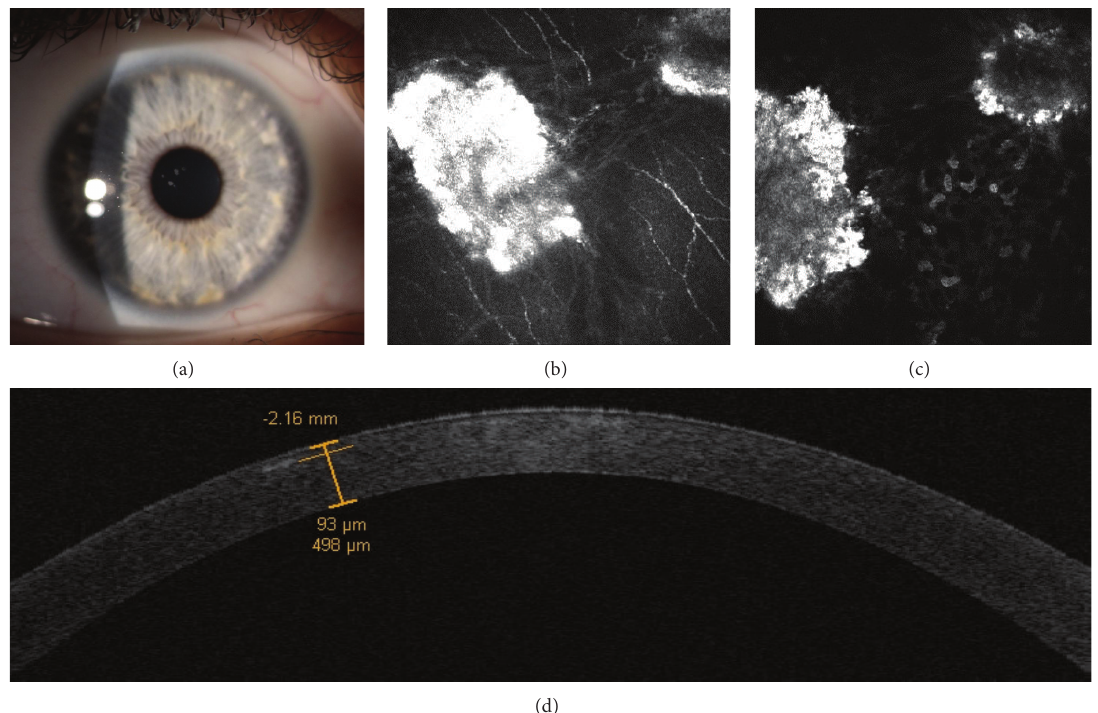
Figure 5: Case 2 , the daughter. Slit-lamp examination shows the presence of few and very tiny patchy stromal opacities, without stellate and linearopacitiesatonset(a).IVCMscansshowthepresenceofgranularhyperreflectivespotswithoutcomplexdepositsamongthesubepithelial nerve fibers and circular hyperreflective deposits (amyloid) surrounding an internal hyporeflective core (hyaline) in the anterior stroma (b and c). Time domain OCT corneal scans provided a wide visualization of the cornea revealing the topographic localization and the depth of corneal deposits